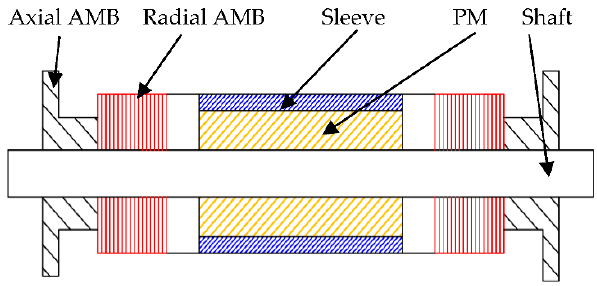
( b ) Figure 8. Stress results of the Titanium alloy sleeve with 3.5 mm: ( a ) the sleeve stress in the radial direction (X ‐ Axis); ( b ) the sleeve stress in the tangential direction (Y ‐ Axis). ( a ) ( b ) Figure 9. Stress results of the PM: ( a ) the PM stress in the radial direction (X ‐ Axis); ( b ) the PM stress in the tangential direction (Y ‐ Axis). 4. Analysis of Air Friction Loss of HSPMSM